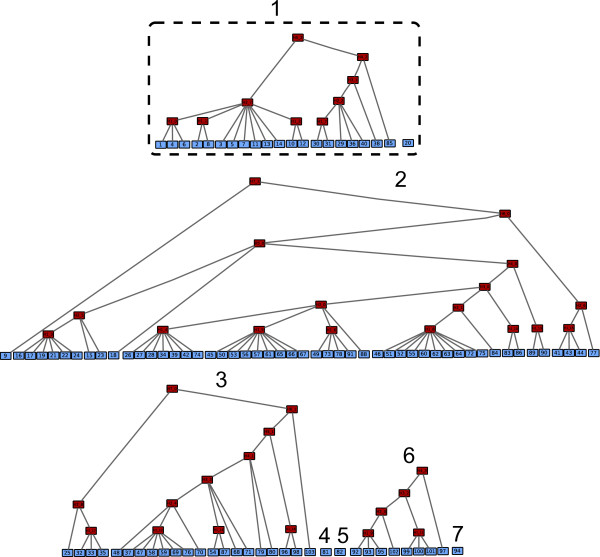
Directed acyclic graph of the FHLC model learned for unphased genotypes of Daly et al.'s dataset. For node nomenclature, see Figure 6. We recall that in any FHLCM graph, edges are directed from top to bottom. a = 0.2, b = 2, cardmax = 20, tCAST = 0.95, tMI = quantileMI (0.95), t = 0. 3 (for CFHLC parameter description, see Section Algorithm).